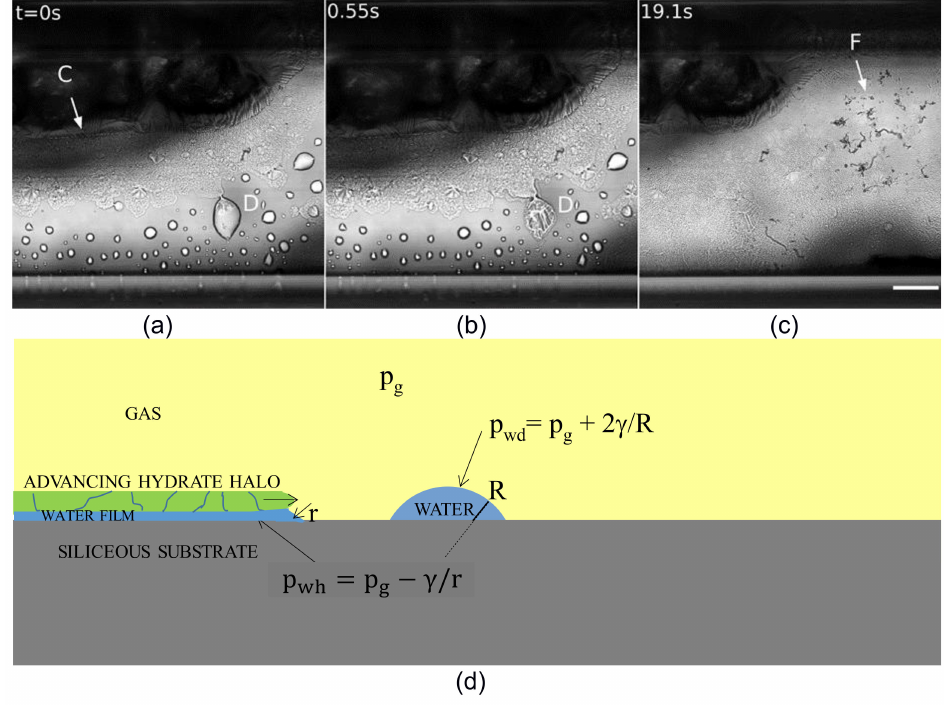
Figure 6. A halo and filaments of methane hydrate observed during a second cycle, at 4 ◦ C, 7 MPa in run 5 on the optical microscope. Images a, b and c are extracted from the Supplementary Materials Video S1. ( a ) Growth of the halo on the glass, from the contact line “C”; ( b ) the halo leapfrogs over a droplet of water on the glass, “D”; ( c ) a few seconds later, the presence of filaments, “F”; ( d ) Schematic of the capillary effect causing rapid displacement of water. Scale bar: 100 µ m. p wh is the pressure of the water under the halo; p wd is the pressure of the water in the drop; p g is the gas pressure; γ is the water–methane interfacial tension; R is the radius of the drop; r is the radius of the water film. Filaments were present but grew at a slower rate and were less developed and numer- ous in run 6 than in run 5 (see Figure 7), presumably because of the lower supercooling.